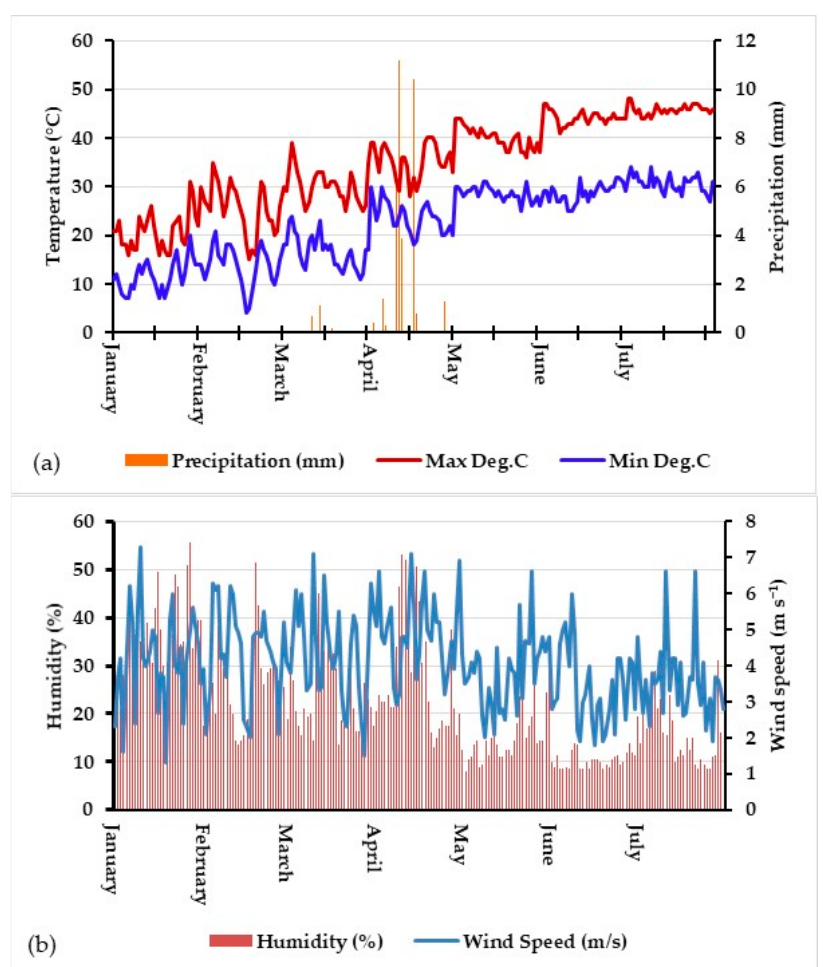
Figure 3. Climatic data: ( a ) daily temperatures and precipitation; ( b ) humidity and windspeed recorded at experimental farm.